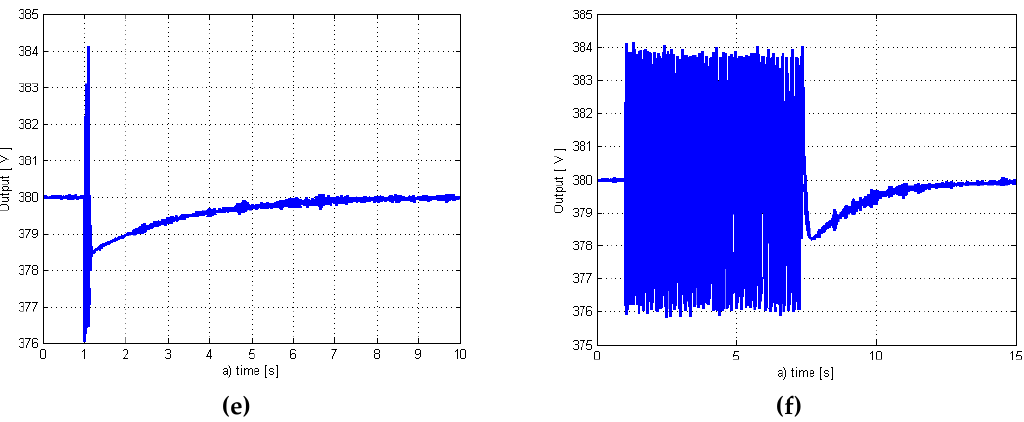
Figure 3. ( a ) Controlled output (terminal voltage)—constant ρ = 0.0001 ( ∆ T m = 16%); ( b ) Figure 3. (a) Controlled output (terminal voltage)—constant (cid:2025) = 0.0001 ( (cid:1986)(cid:1846) (cid:3040) = 16% ); (b) Controlled